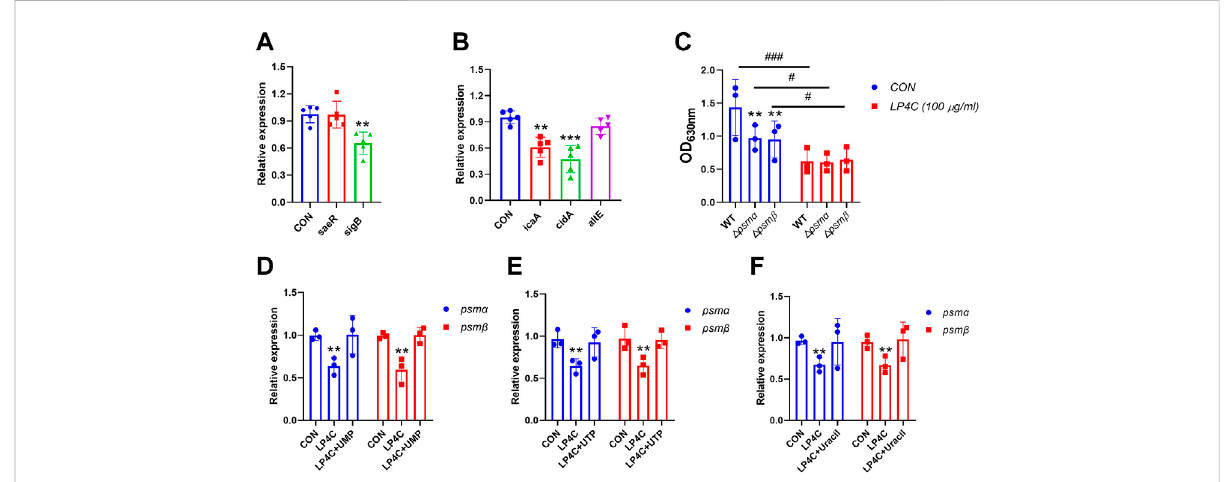
The effectof LP4Cto theexpressionof MRSA bio fi lmformation associated genes. Theeffect ofLP4C (100 μ g/ml)to theexpressionof sarR and sigB in MRSA USA 300, ** p < 0.01 vs . control (CON), n = 5 (A) . The effect of LP4C (100 μ g/ml) to the expression of icaA , cidA and altE, data were normalized to levels of gyrB and calculated as fold changes, ** p < 0.01, *** p < 0.001 vs . control (CON), n = 5 (B) . The impaired bio fi lm formation capability of mutated psm α ( △ psm α ) or psm β ( △ psm β ) MRSA USA300, ** p < 0.01 vs . wild type (WT) MRSA USA300, # p < 0.05, ### p < 0.0001 vs